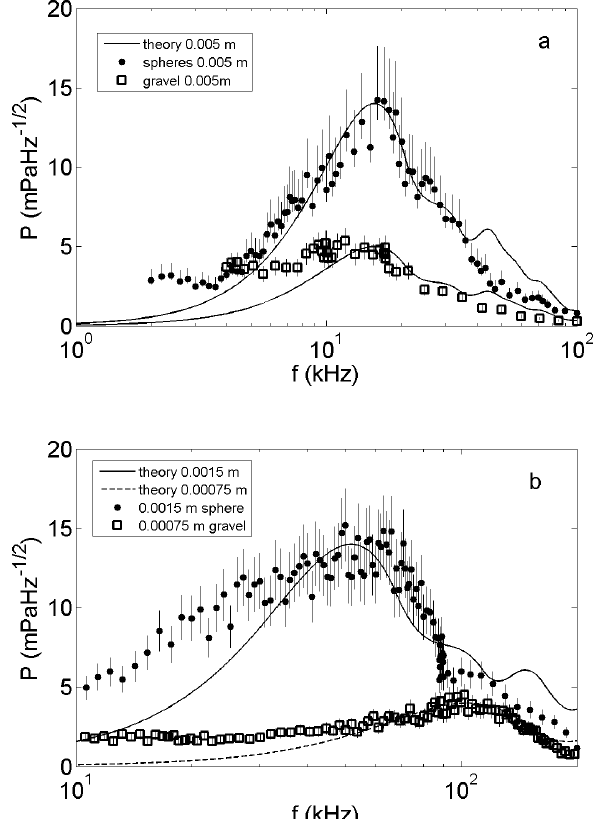
Figure 6. Comparison of the measured and calculated spectra us- ing Eq. (2) with smoothing, for quasi-bedload conditions in a ro- tating drum for; (a) 0.005m radius glass spheres and gravel and (b) 0.0015m radius glass spheres and 0.00075mm radius gravel. Measurements ( • ) are from Thorne (1985), and ( (cid:3) ) are from Thorne